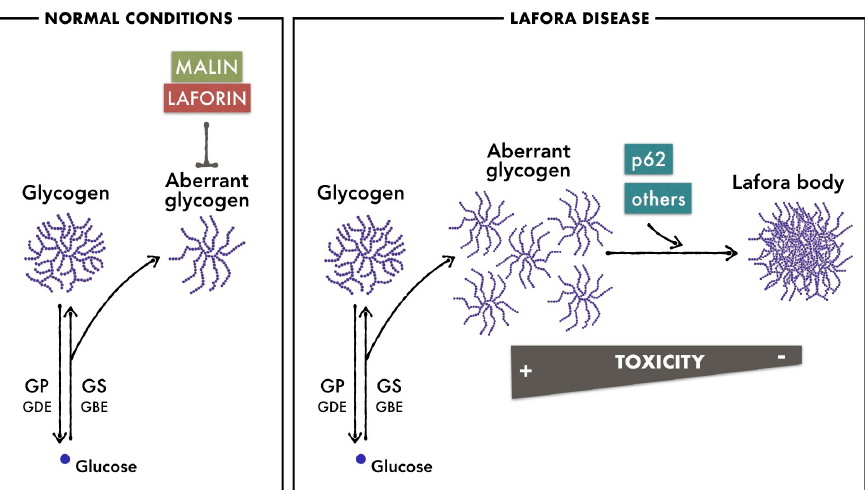
Figure 1. Brain glycogen metabolism in normal conditions and in LD. In normal conditions, malin and laforin prevent the accumulation of poorly branched glycogen that is generated as a side prod- uct of glycogen metabolism. In LD, due to the absence of malin or laforin, poorly branched glycogen accumulates in astrocytes and neurons. Proteins like the autophagy adaptor p62 promote its aggre- gation in the form of LBs to minimize the toxic consequences of its accumulation.